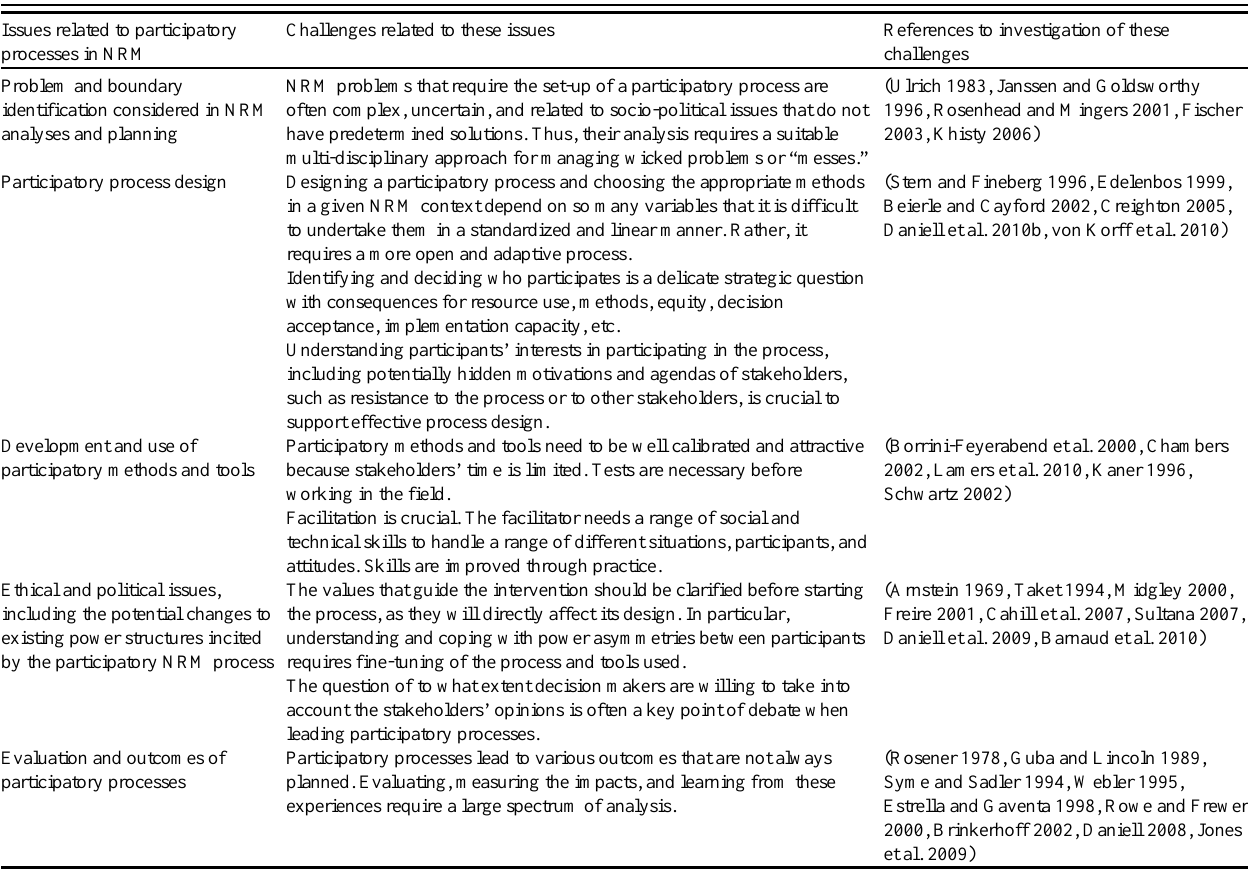
Table 1. Some key challenges related to participatory processes in